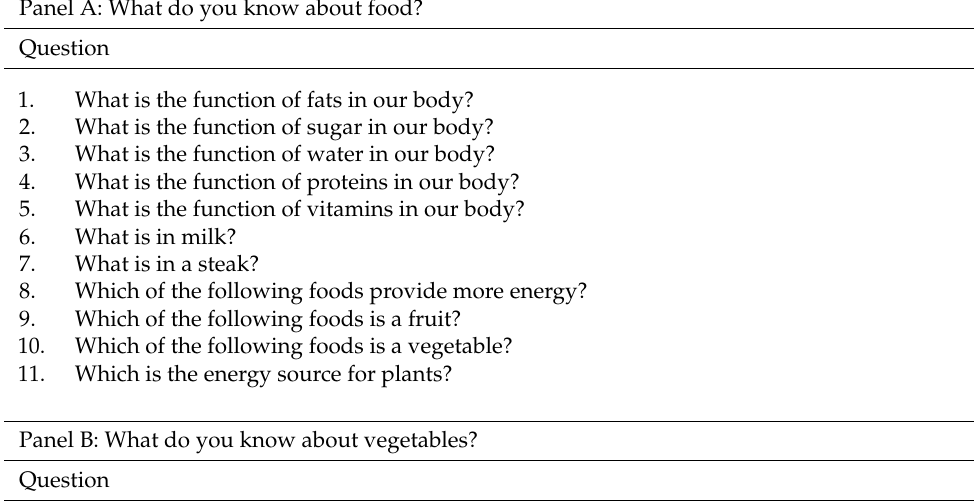
Table 1. Questionnaire for the students.